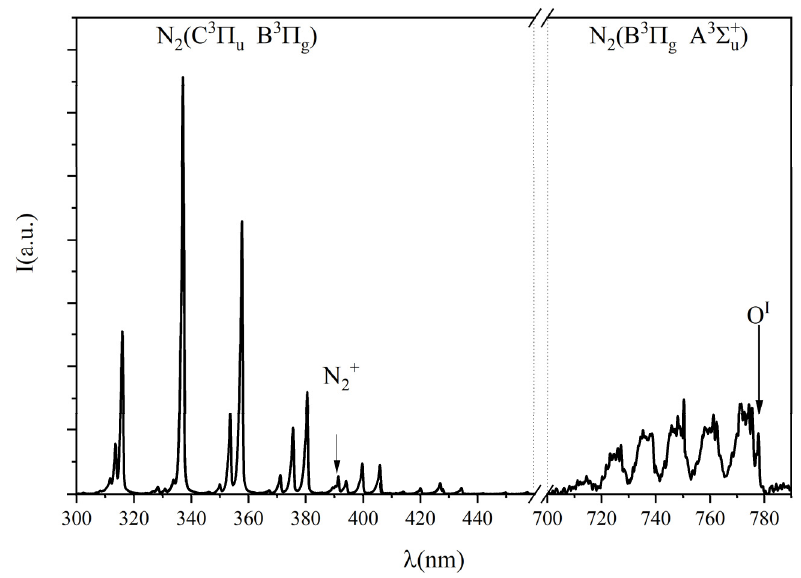
Figure 3. Typical averaged (1000 shots) electron impact induced emission spectrum intensity (I(a.u.)) as a function of wavelength ( λ (nm)) over multiple discharge filaments developing over the entire ON time AC HV burst.